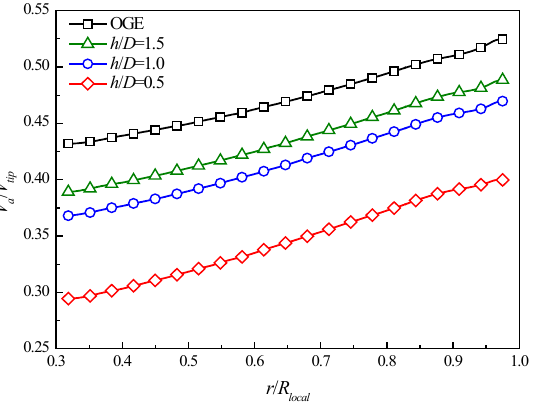
Figure 17. Radial distribution of azimuthally averaged axial velocity on cross section at ξ/c d =0.39.